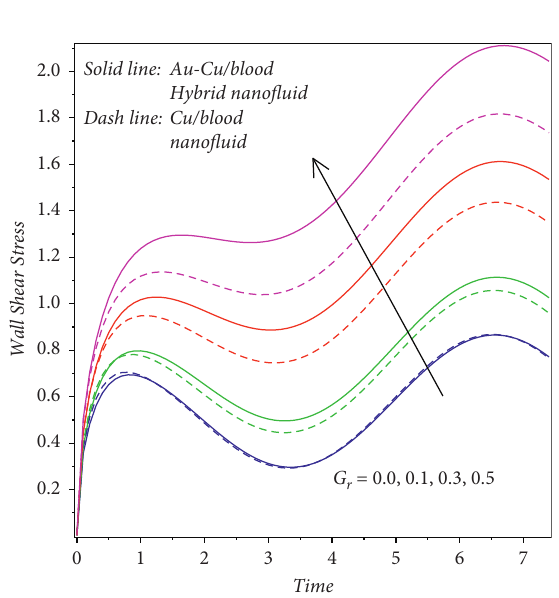
Figure 19: Behaviour of G